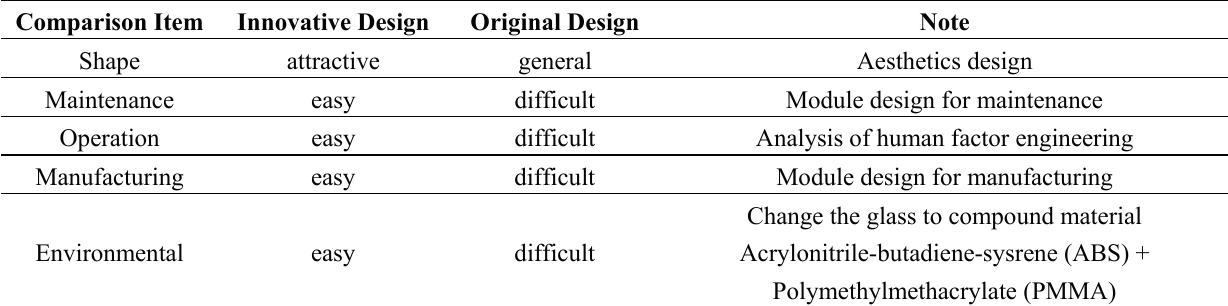
Table 14. The comparison of innovative shape design and original shape design. Comparison